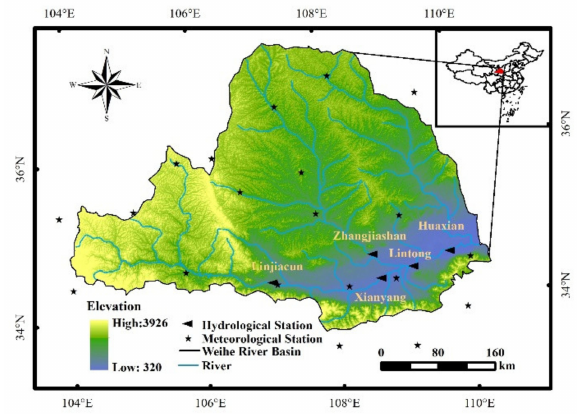
Figure 1. The location of the Weihe River